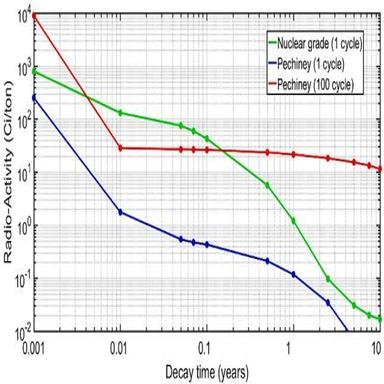
Radioactivity levels in irradiated graphite targets.